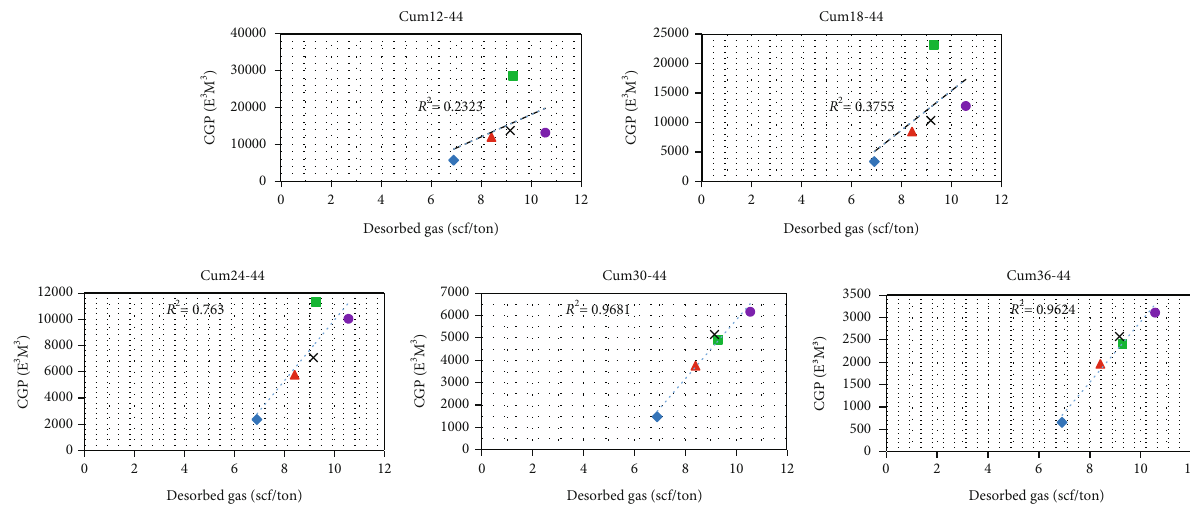
Figure 12: Desorbed gas versus cum gas production history cross-plots. From cum 12-44 to cum 36-44 represents to the cumulative gas production by month. The correlation coe ffi cient increases toward the cum 36-44 indicates that estimated desorbed gas was more correlative at the end of gas production. Each mark represents the well use for the comparison and included in Table 4. R 2 represents correlation coe ffi cient.